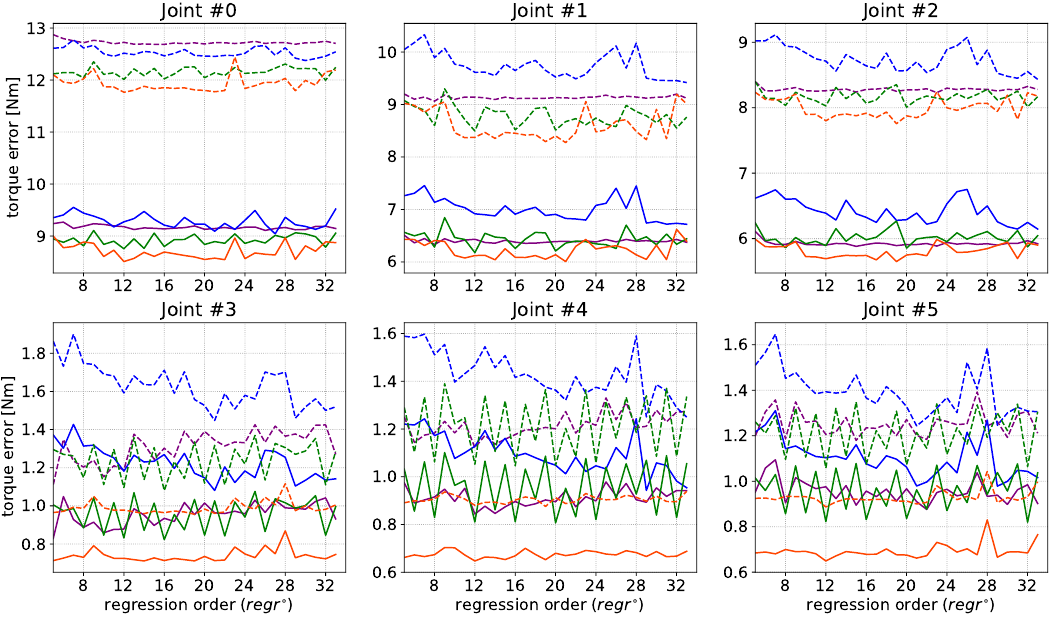
( a ) Mean error of predicting engine torque at each joint. Figure 4.